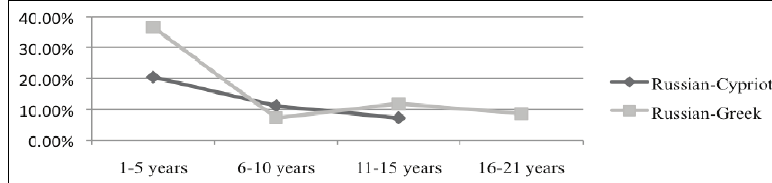
Figure 3: LoR of the participants and non-target test production